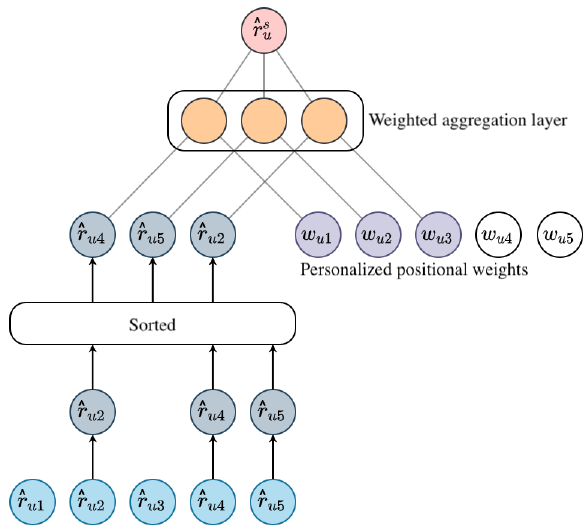
Figure 4. An illustrative example of position-aware rating aggregation. Suppose items i 2 , i 4 , i 5 are selected from a set of items { i 1 , i 2 , i 3 , i 4 , i 5 } by SaPN. The set-rating predictions ˆ r s u are obtained by aggregating i 2 , i 4 , i 5 with personalized positional weights w u 1 , w u 2 , w u 3